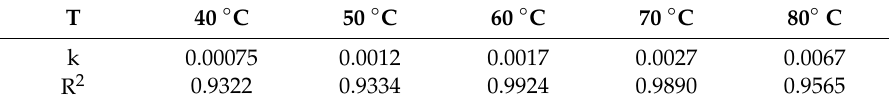
Figure 7. Plots of the shrinking-core model for chemical reaction control for Pd leaching. Table 3. The kinetics parameters of chemical reaction control model for Pd leaching.